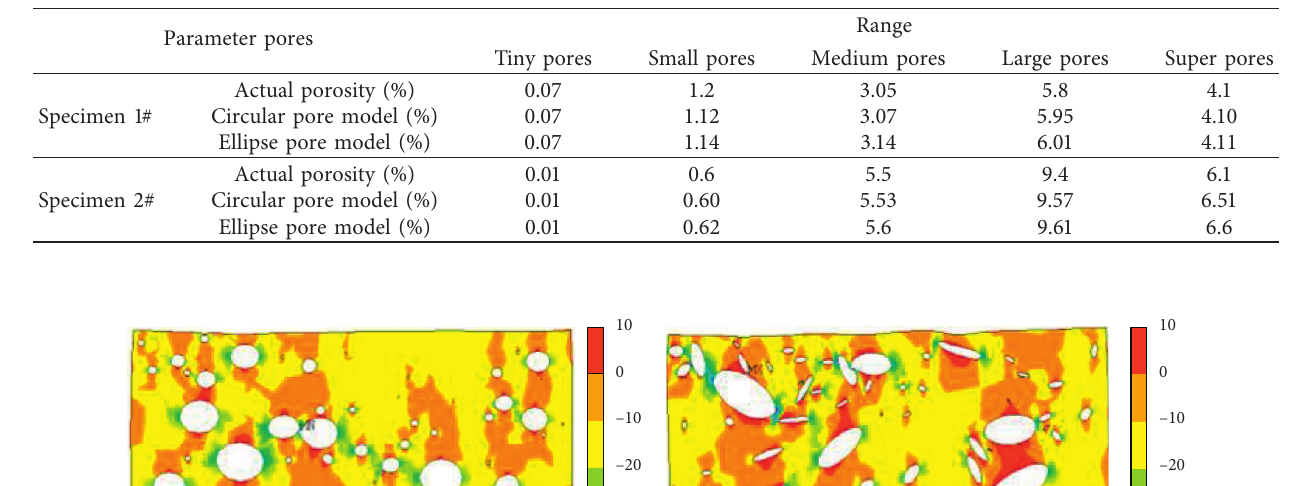
Table 7: Porosity comparison between FEM and reality.